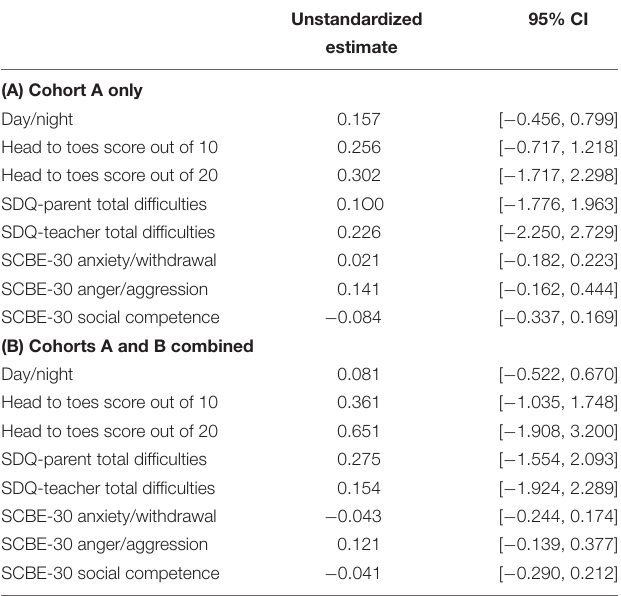
TABLE 4 | Results for effect of curriculum moderated by initial language ability. Unstandardized 95% CI